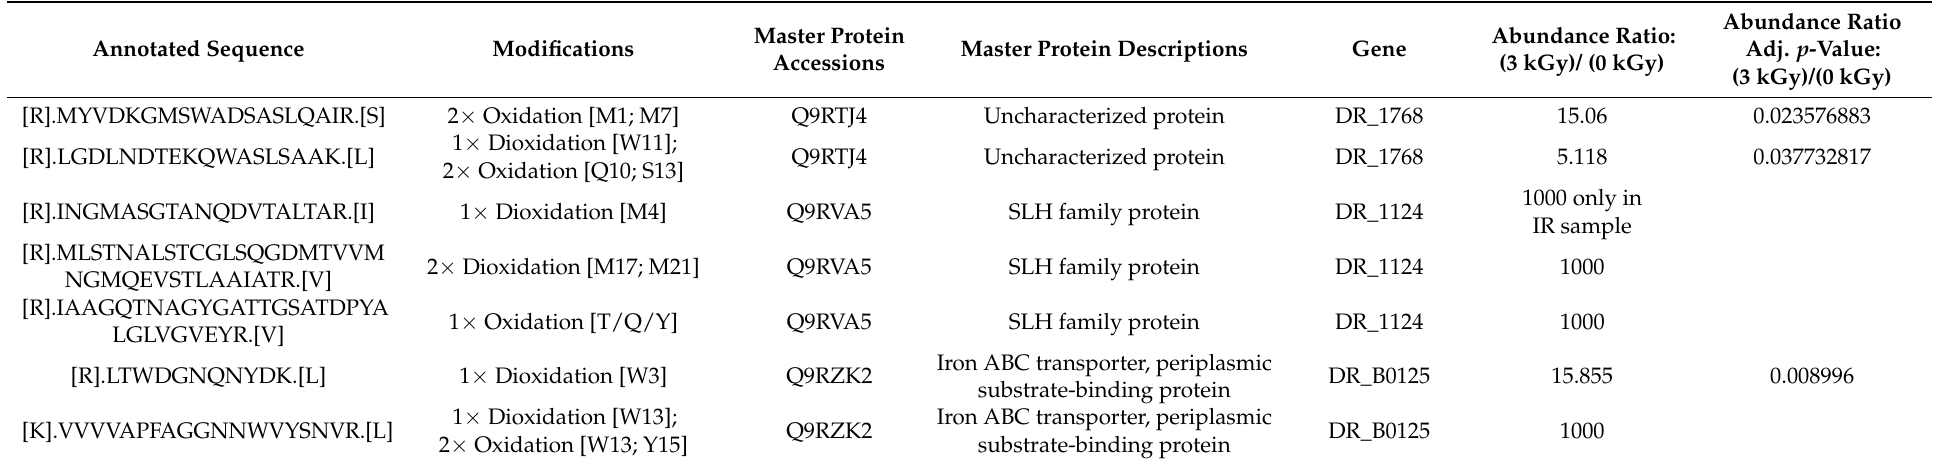
Table 8. Prominent oxidation events caused by irradiation at 3000 Gy in Deinococcus radiodurans